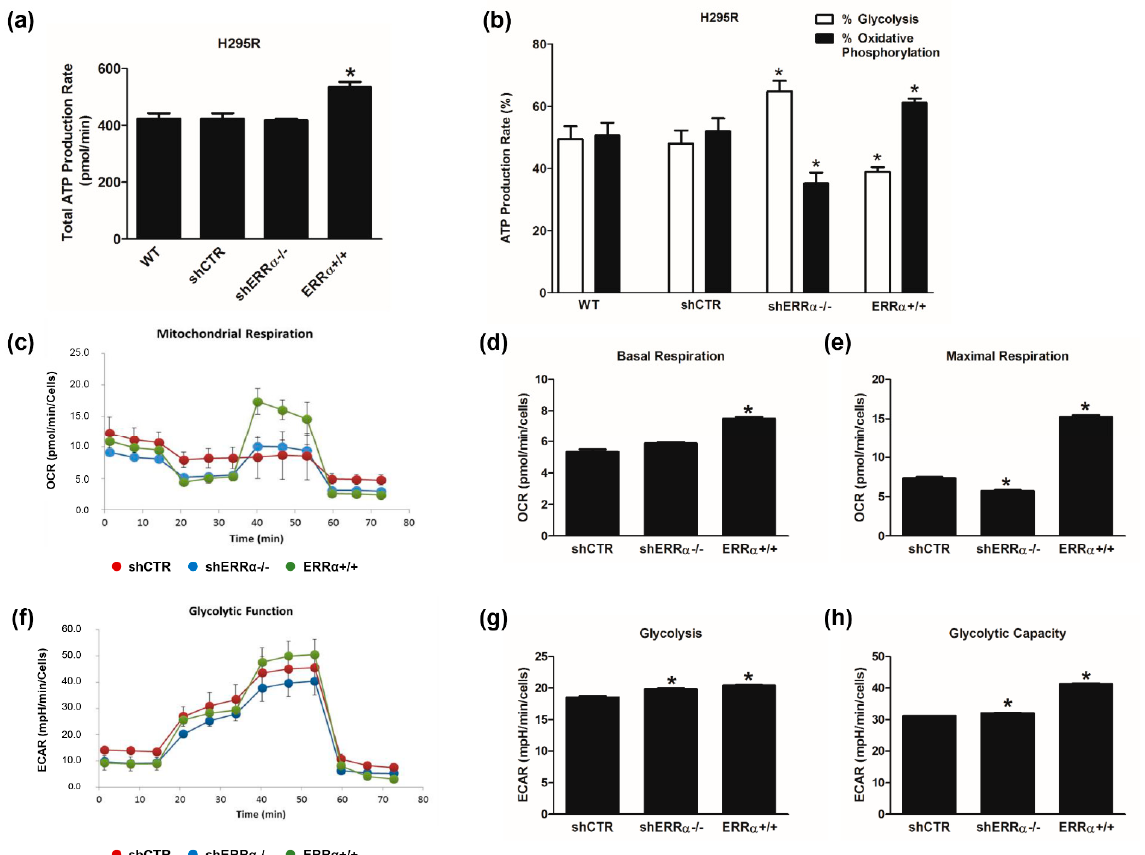
Figure 2. Metabolic changes in H295R cells related to ERR α expression levels. The metabolic profiles of H295R wild type (WT), shCTR, shERR α − / − and ERR α +/+ cells were assessed by Seahorse XFe96 Analyzer. ( a , b ) ATP Rate Assay was evaluated as indicated in “Materials and Methods”. Graphs represent the mean ± SD of three independent experiments of Total ATP Production Rate (pmol/min) ( a ) and ATP production (%) ( b ) deriving from glycolysis and oxidative phosphorylation after the sequential addition of specific inhibitors; (* p < 0.05 vs. WT). ( c – e ) Mitochondrial Stress Analysis was performed as indicated in “Materials and Methods”. Graphs represent the mean ± SD of three independent experiments of real-time oxygen consumption (OCR) rate (pmol/min/cells); (* p < 0.05 vs. shCTR). Mitochondrial Respiration ( c ), Basal Respiration ( d ), Maximal Respiration ( e ) were measured from OCR after the addition of specific inhibitors. ( f – h ) Glycolytic Stress Analysis was performed as indicated in “Materials and Methods”. Graph represents the mean ± SD of three independent experiments of Real-time extracellular acidification (ECAR) rate (mpH/min/cells); (* p < 0.05 vs. shCTR). Glycolitic function ( f ), Glycolysis ( g ) and Glycolytic Capacity ( h ) were measured from ECAR after the addition of specific inhibitors.